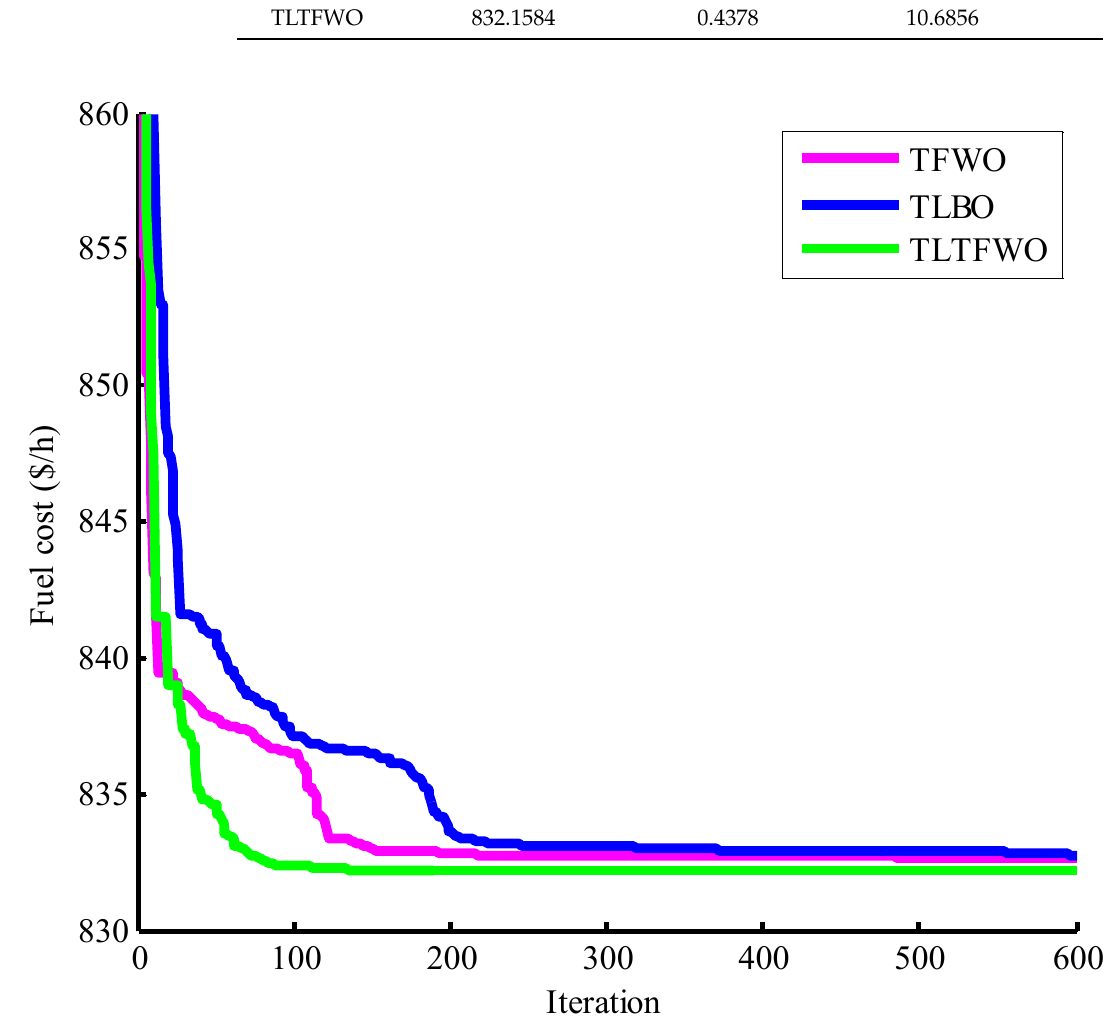
Figure 7. Convergence trends in Case 3.